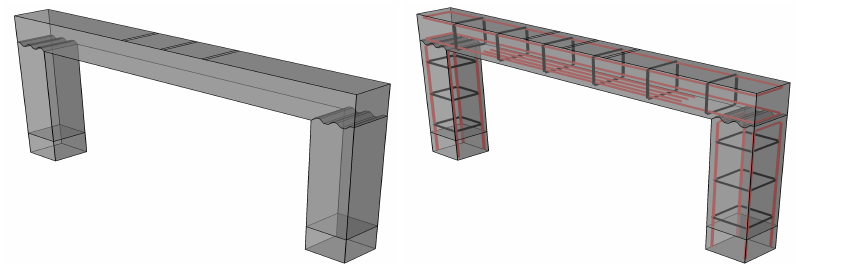
Figure 11. F4, Rebar layout and geometrical dimensions.